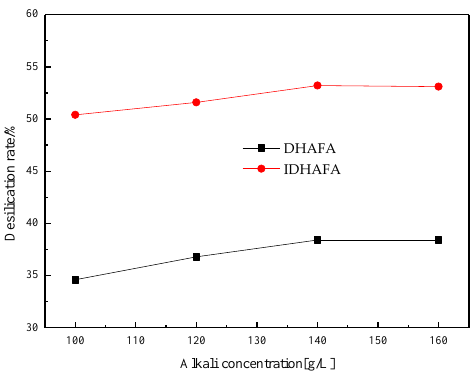
Figure 5. Effect of alkali concentration on the desilication rate of IDHAFA and DHAFA (Predesilication conditions: T = 95 °C, L/S = 3.5, and t = 150 min).